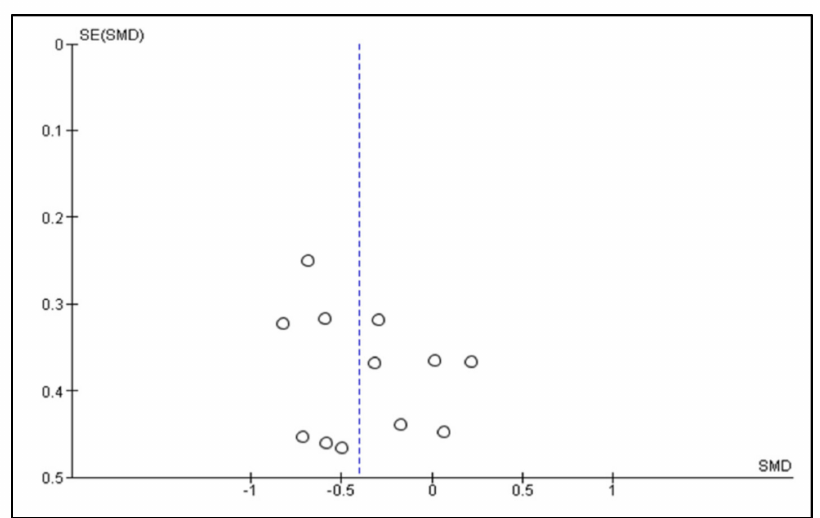
Figure 12. Funnel plot summary for secondary functionality improvement (MMO) from baseline up to the final follow-up